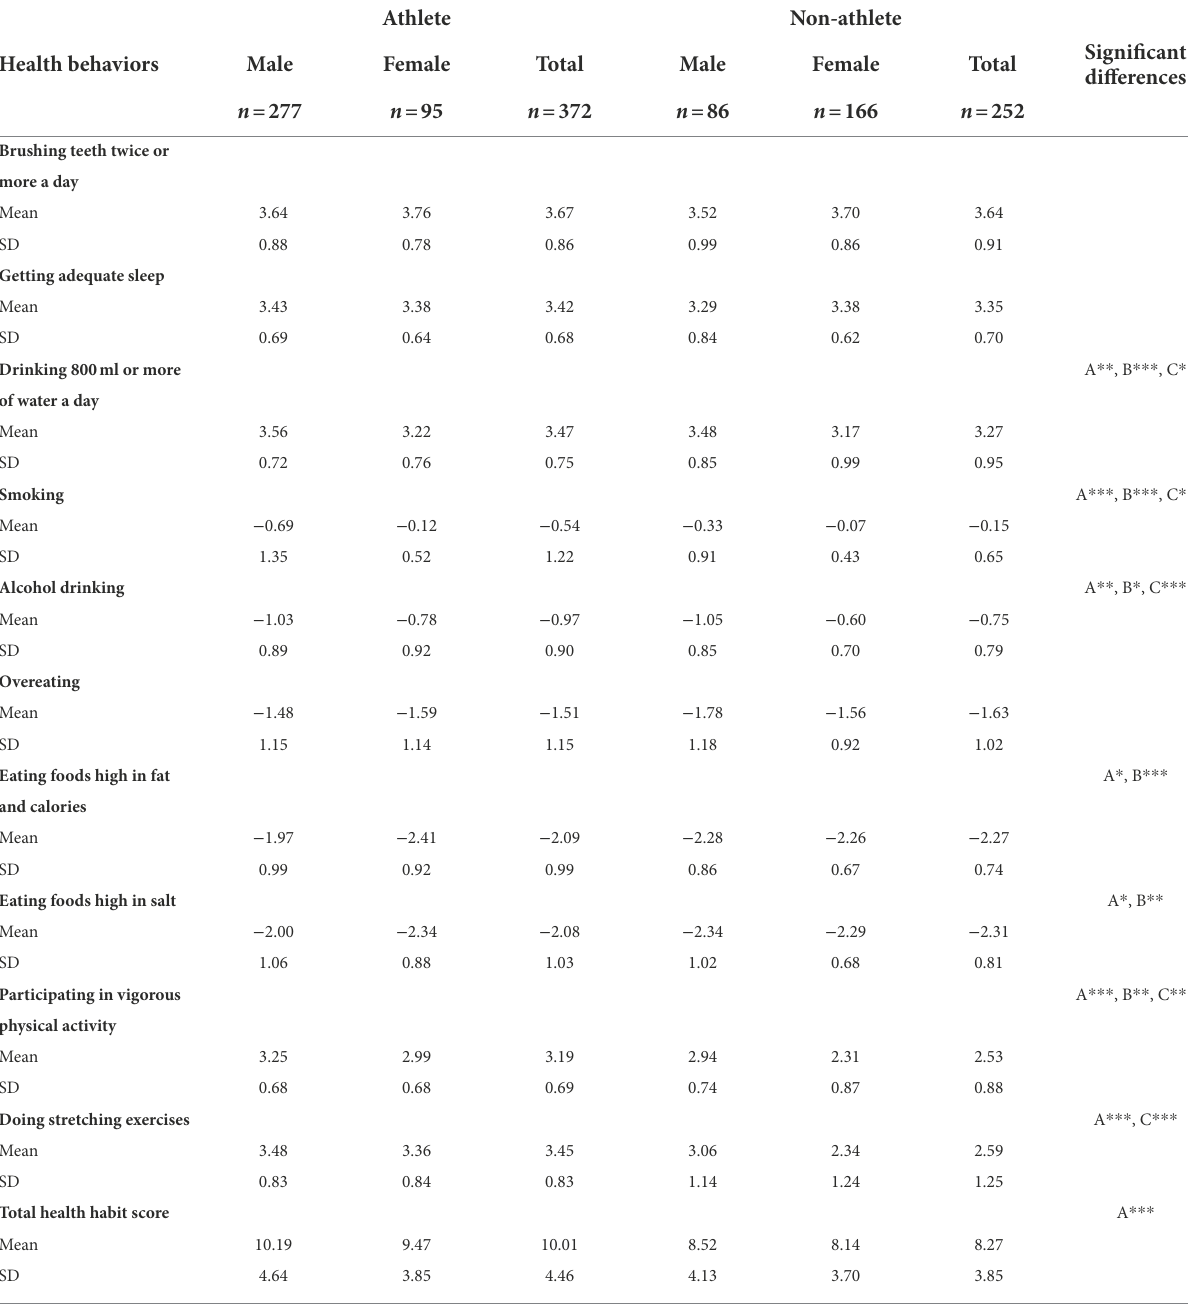
TABLE 2 Health habit